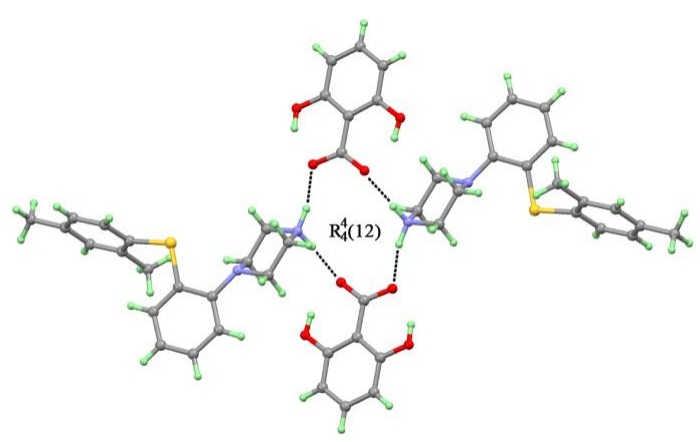
Figure 3. ( a ) Two 25BA anions formed an R 2 3D structure of the VOT-25BA salt.